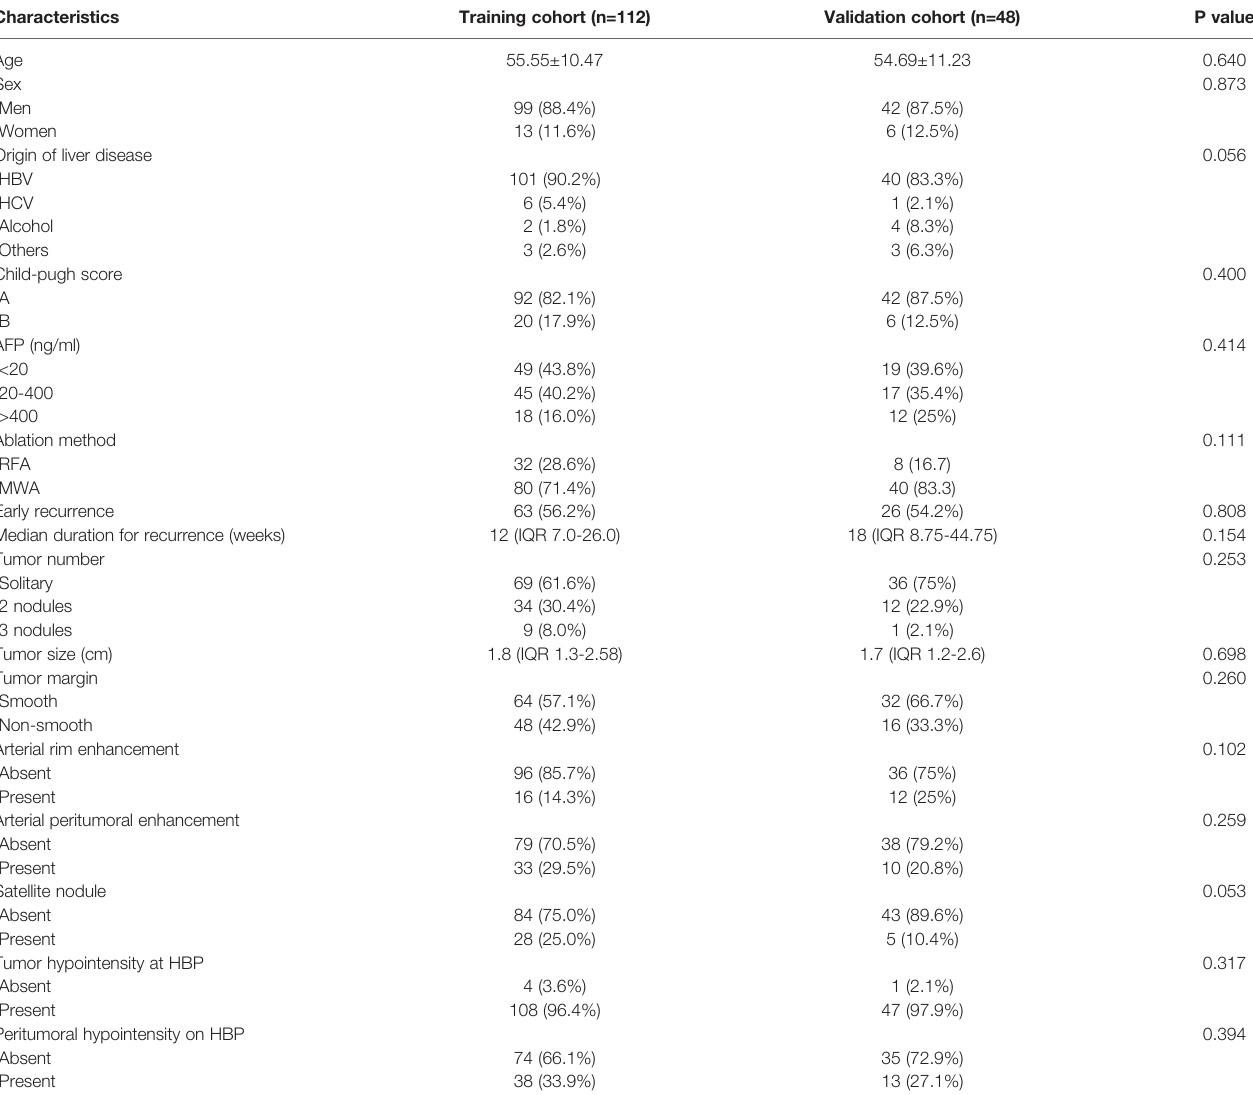
TABLE 1 | Demographic and clinical characteristics in training and validation cohort. (n=160).